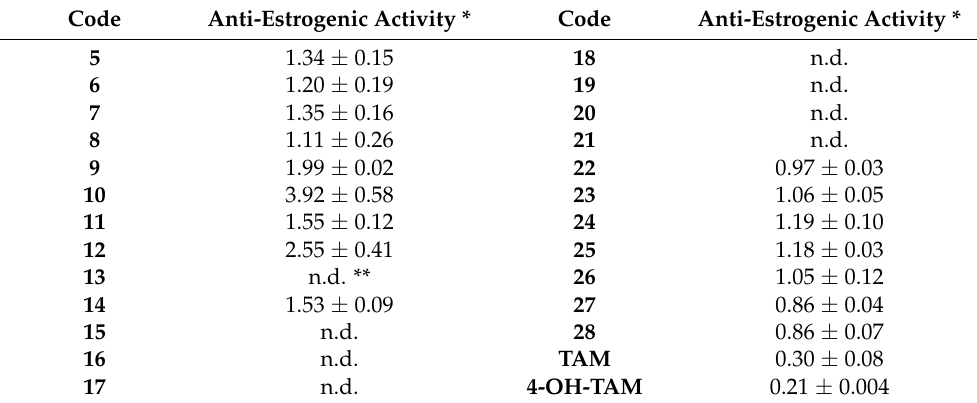
Table 2. Relative β -galactosidase activity using YES assay (antagonistic